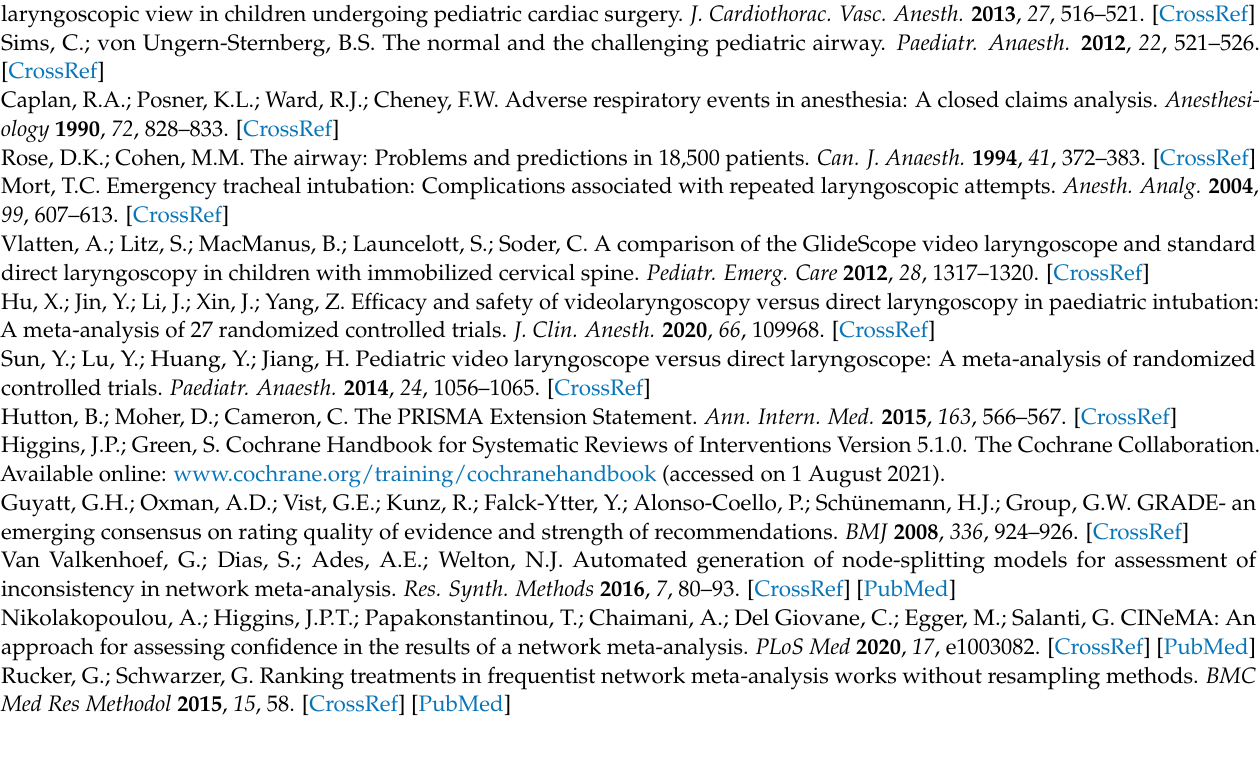
ological domain of risks of bias, Figure S3: Meta-analysis flow chart, Figure S4: League table of the primary outcome, Figure S5: Results of inconsistency of the primary outcome, Figure S6: Results of funnel plot of the primary (A) and secondary outcome (B,C), Figure S7: League table of the secondary outcome (glottic visualization), Figure S8: Results of inconsistency of the secondary outcome (glottic visualization), Figure S9: Summary of findings table for the secondary outcome (glottic visualiza- tion), Figure S10: League table of the secondary outcome (intubation time), Figure S11: Results of inconsistency of the secondary outcome (intubation time), Figure S12: Summary of findings table for the secondary outcome (intubation time), Figure S13: Forest plot of the subgroup analysis, Figure S14: The results of subgroup analysis by P score ranking, Figure S15: The results of funnel plot of the subgroup